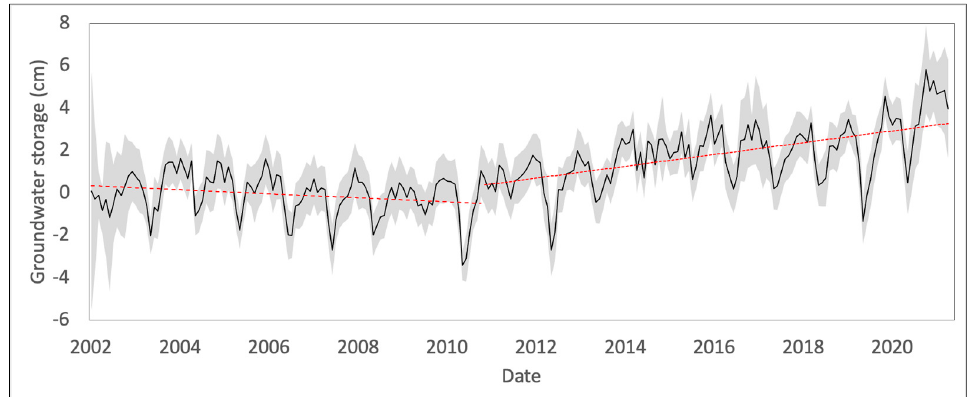
Figure 12. Groundwater storage anomaly change in the Chad basin region.